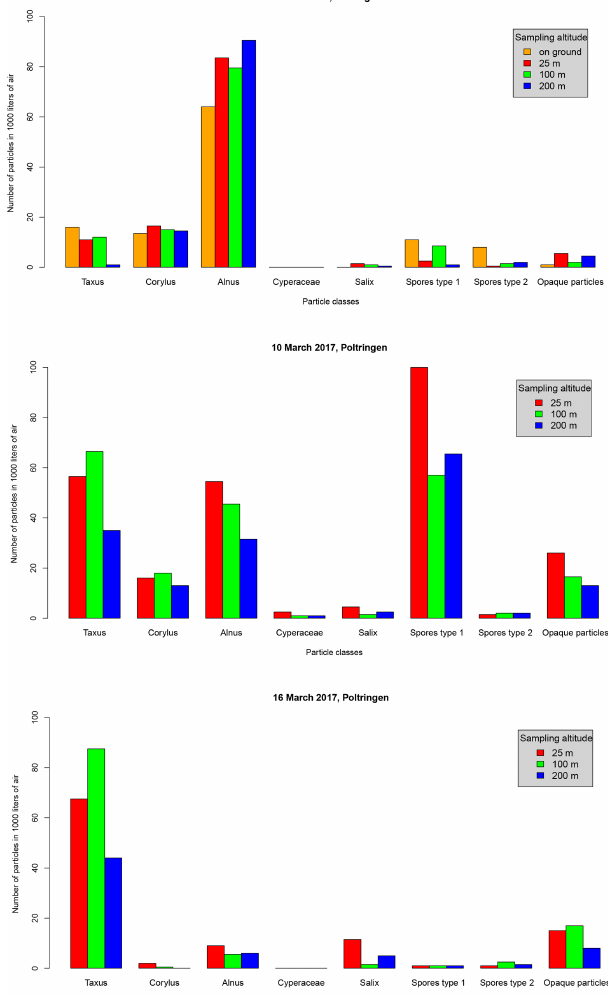
Figure 10. Graphical representation of the measured concentrations of particles (in particles perm 3 of sampled air) collected during the aerosol particle collection flights on 3, 10, and 16 March 2017. Colour differences in the individual bars represent the particle con- centration at different altitudes. It should be noted that only on 3 March 2017, a sampling operation was carried out on the ground with the propellers of the multicopter UAV switched off. On that date, sampling operations were carried out also at altitudes of 25m, 100m, and 200ma.g.l., whereas on 10 and 16 March 2017 sam- pling operations were carried out at altitudes of 25m, 200m, and 300ma.g.l.,